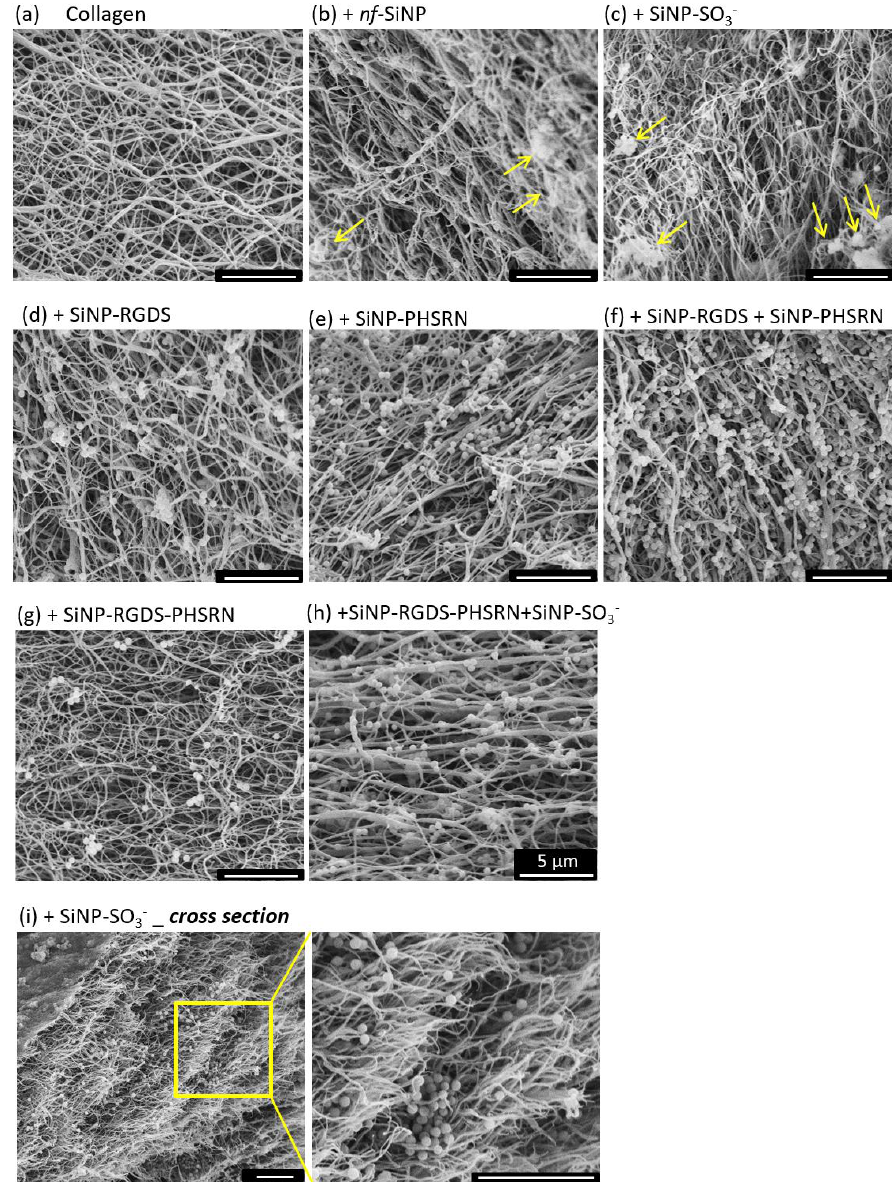
Figure 6. SEM images of ( a ) collagen, ( b ) + nf -SiNP, ( c ) + SiNP-SO 3 − , ( d ) + SiNP-RGDS, ( e ) + SiNP-PHSRN, ( f ) + SiNP-RGDS + SiNP-PHSRN, ( g ) + SiNP- RGDS-PHSRN, and ( h ) + SiNP-PHSRN-RGDS + SiNP-SO 3 − , and ( i ) cross section of the collagen + SiNP-SO 3 − biocomposite. Yellow arrows indicate nanoparticle aggregates. The scale bar is 5 μ m for all images.